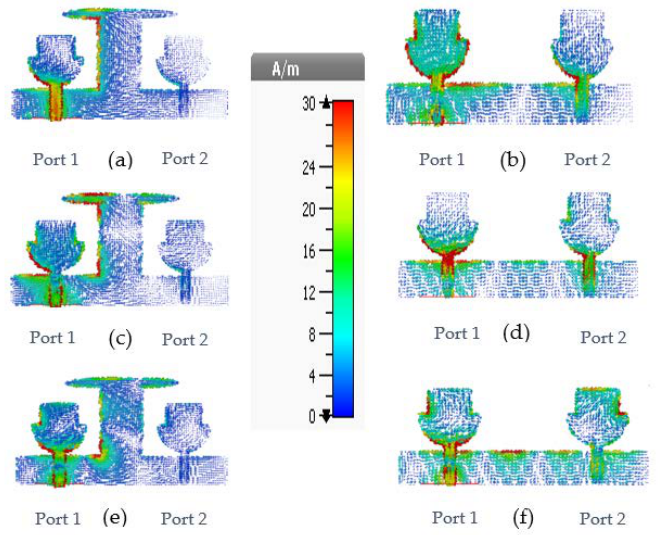
Figure 5. Surface current distribution of proposed MIMO antenna at ( a ) 5 GHz with decoupling stub ( b ) 5 GHz without decoupling stub ( c ) 10 GHz with decoupling stub ( d ) 10 GHz without decoupling stub ( e ) 15 GHz with decoupling stub ( f ) 15 GHz without decoupling stub.